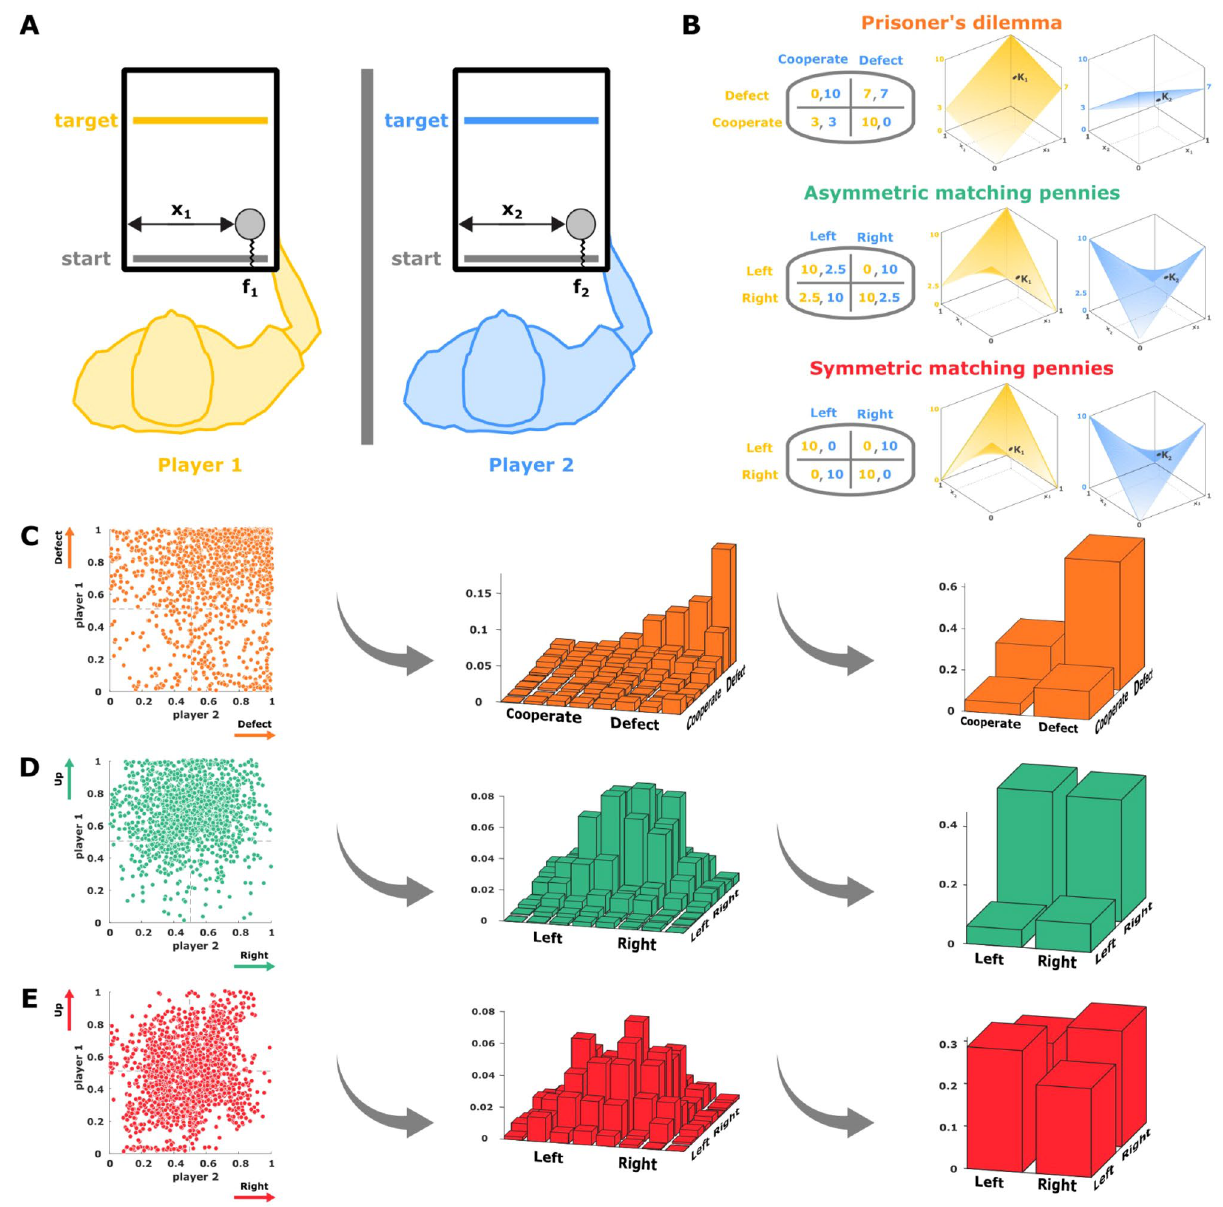
Figure 1. Experimental setup. ( A ) Sensorimotor game. Subjects were sitting next to each other without communication, and interacted through two handles that generated a force on their hand opposing their forward movement. ( B ) Payoff matrices for each one of the 3 games. The 2-by-2 payoff matrices determine the boundary values of the force payoffs at the extremes of the x 1 x 2 -space for both players (left). Interpolation of the payoffs defining a continuous payoff landscape for a continuum of actions (right). ( C ) Subjects’ results in the continuous prisoner’s dilemma game. Final decisions shown as a scatter plot in the x 1 x 2 -space (left), where the single pure Nash equilibrium is located in the top-right corner at (1,1). The same responses binned into an 8-by-8 histogram (middle), and the corresponding categorical representation (right). ( D ) Subjects’ results in the continuous asymmetric matching pennies game. Final decisions (left), where the mixed Nash equilibrium strategies have expectation (0.8, 0.5). The same responses binned into an 8-by-8 histogram (middle), and the corresponding categorical representation (right). ( E ) Subjects’ results in the continuous matching pennies. Final decisions game (left), where the mixed Nash equilibrium strategies have expectation (0.5, 0.5). The same responses binned into an 8-by-8 histogram (middle), and the corresponding categorical representation (right). Created using MATLAB R2021a (https:// www. mathw orks. com) 43